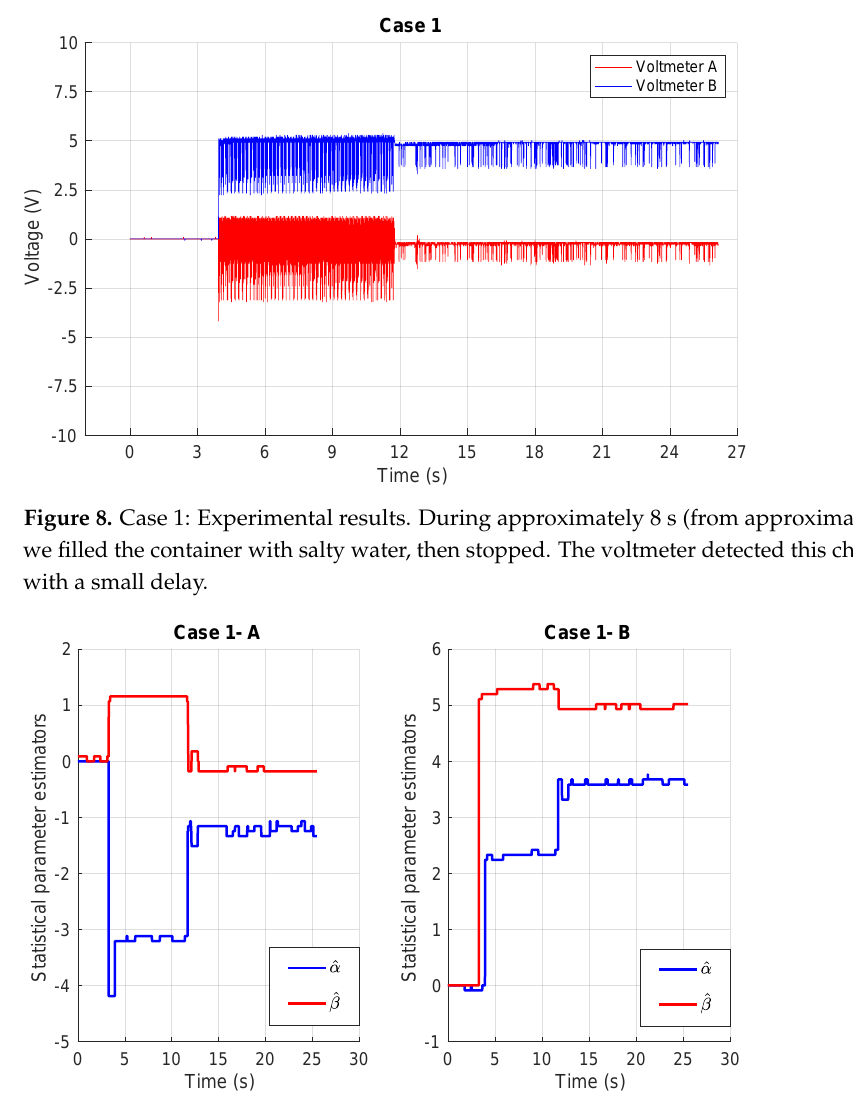
Figure 9. Case 1: Data analysis evolution of the likelihood estimation of the decision parameters ˆ α and ˆ β (6). At approximately 12 s, both parameters detected different soil